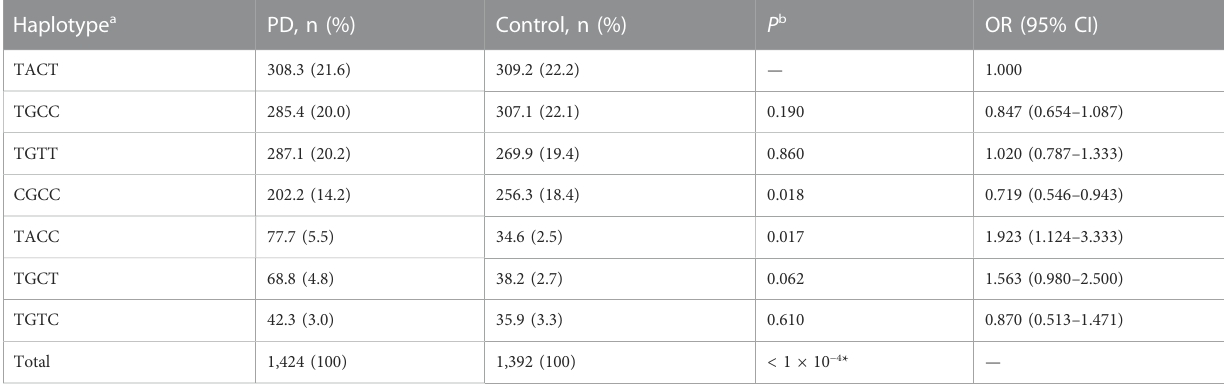
TABLE 3 Haplotype analysis of DNMT1 tag-SNPs in PD patients and controls. Haplotype a